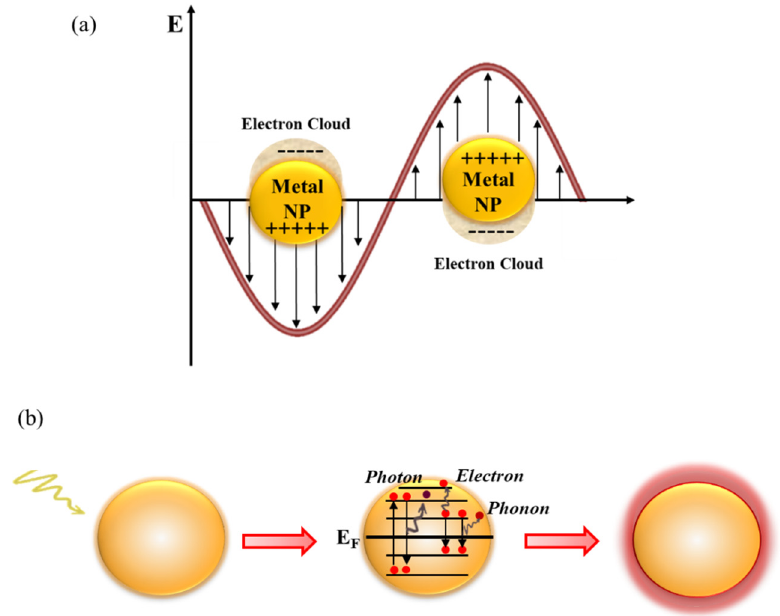
Figure 2. ( a ) Schematic illustration of localized surface plasmon resonance (LSPR). ( b ) Decay channels for plasmonic excitation: electron-to-photon, electron-to-electron, and electron-to-phonon. (NP = plasmonic nanoparticle; E F = Fermi level).